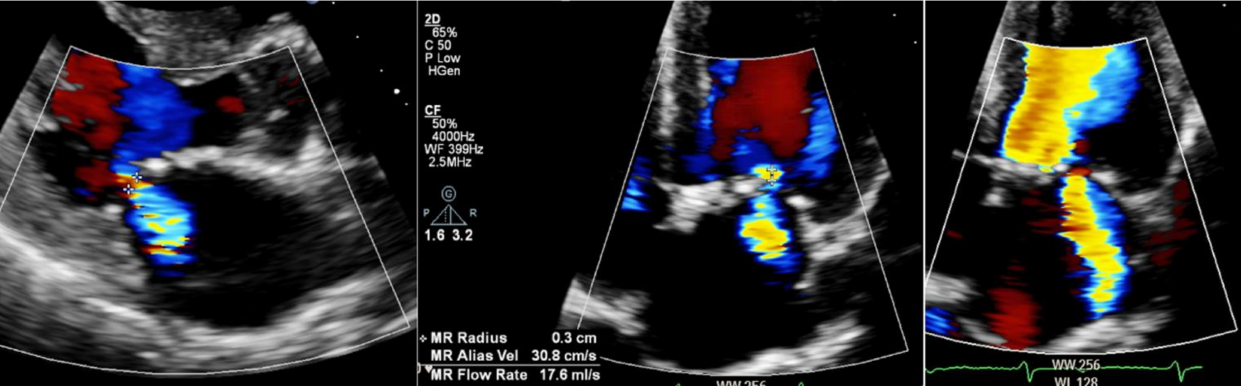
Figure 10. The 2D TTE MR assessment in an adult with advanced Fabry cardiomyopathy and co- existing end stage renal disease. ( Left ) Parasternal long axis view demonstrating LVH, left atrial dilatation, bilateral annular calcification of the mitral valve (causing basal restriction) with moderate MR evident on colour Doppler and vena contracta of 0.4 cm (moderate); ( Middle ) Apical 4-chamber view demonstrating bilateral annular calcification of the mitral valve with MR on colour Doppler and proximal isovelocity surface area (PISA) measurement of 0.3 cm (moderate); ( Right ) Apical 4-chamber view demonstrating moderate MR on colour